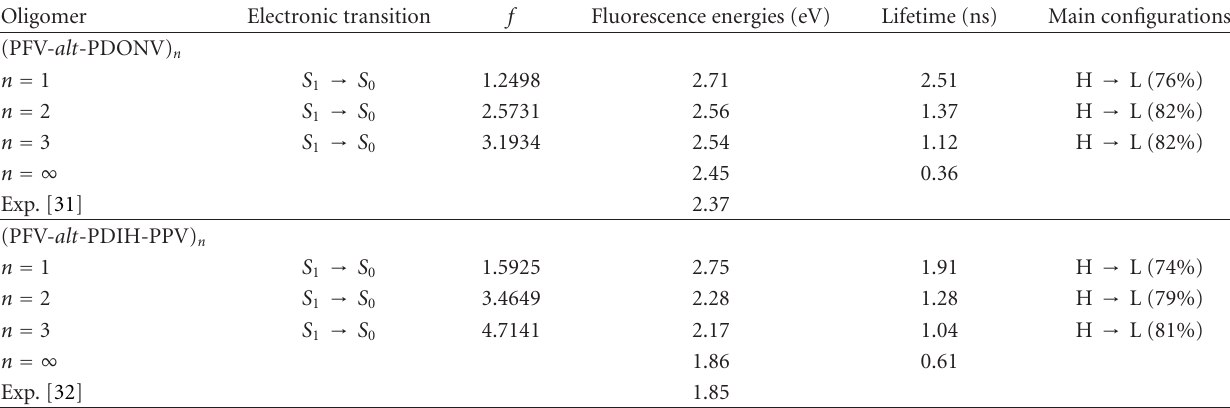
Figure 5: Comparison of the excited structures ( S 1 ) by CIS/6-31G(d) with the ground structure ( S 0 ) by HF/6-31G(d) ( n = 2) for PFV- alt - PDONV and PFV- alt -PDIH-PPV. Table 6: Fluorescence energies and radiative lifetime of PFV- alt -PDONV and PFV- alt -PDIH-PPV ( n = 1–3) obtained by TDDFT//B3LYP/6-